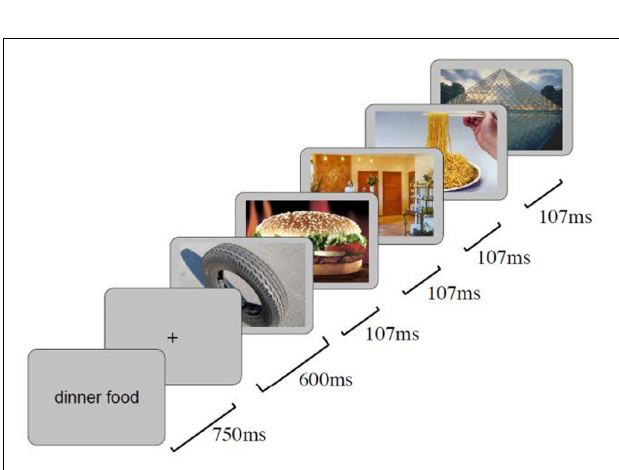
FIGURE 5 |An example of an RSVP sequence in a search experiment in which participants reported the specific names of two exemplars of the search category. Here the exemplars are hamburger and spaghetti. From Potter et al.